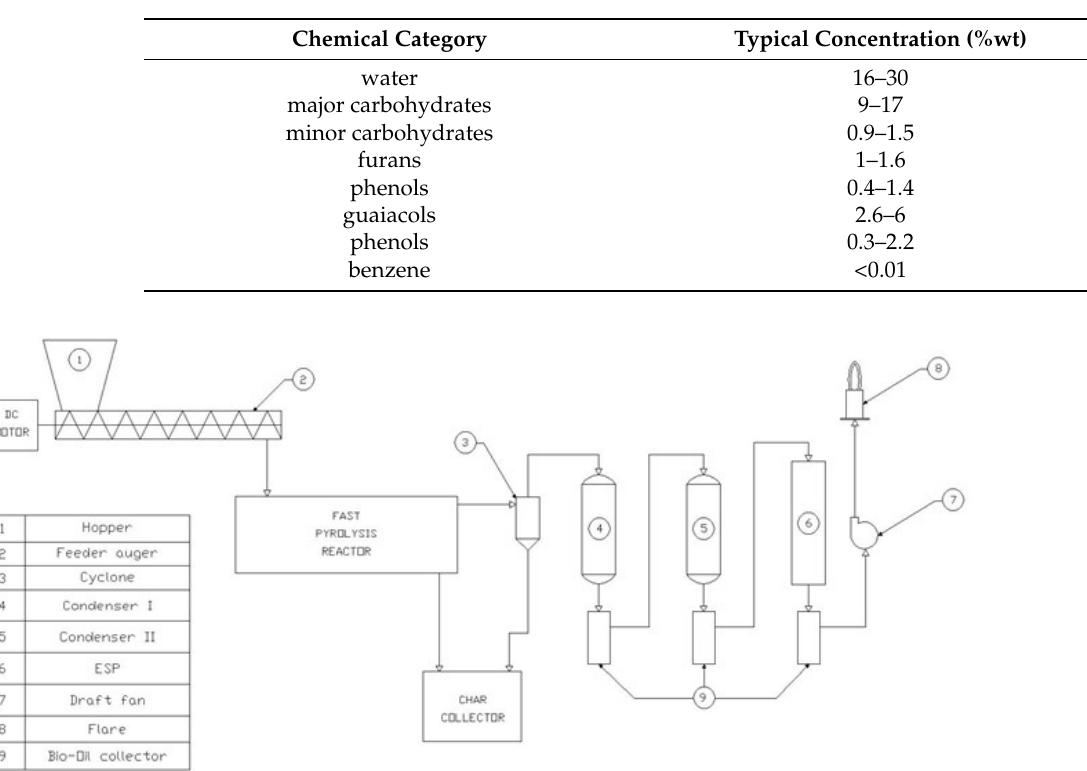
Figure 2. Simplified flow diagram of a typical FP